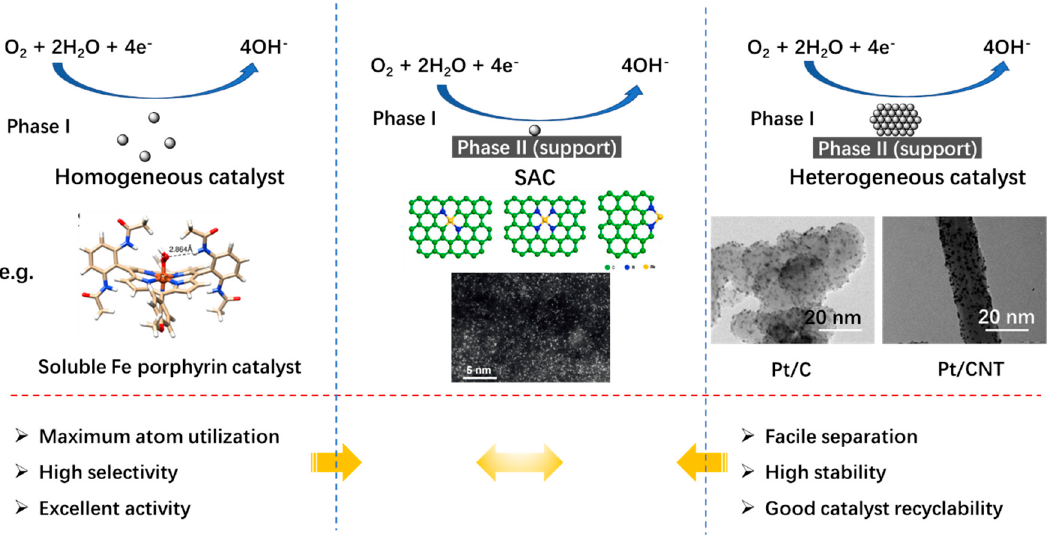
Figure 3. Comparison of diverse catalysis systems for the oxygen reduction reaction (ORR) in alkaline media and the corresponding merits for the corresponding catalysts. The pictures were adopted from [40–43].